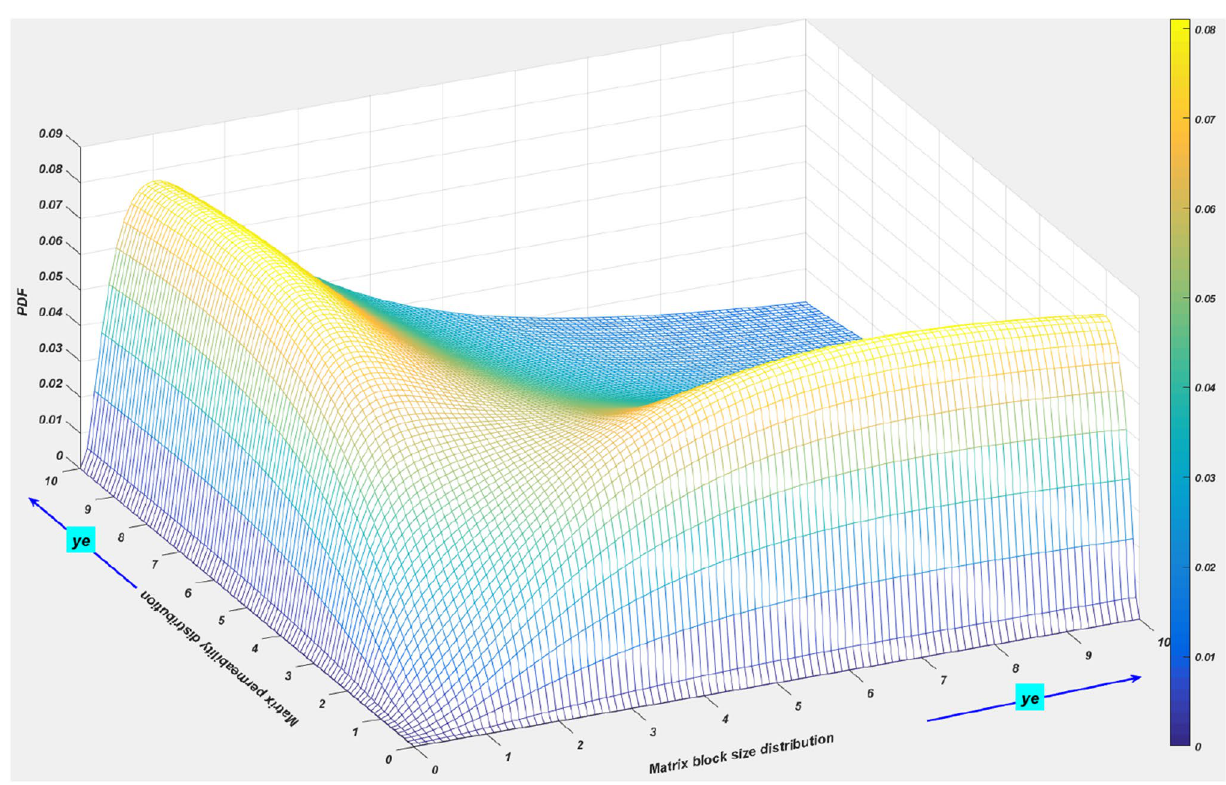
Fig. 1 Log-Normal distribution and probability distribution function (PDF) of the matrix block size and permeability in hydraulically fractured reservoirs (Al-Rbeawi